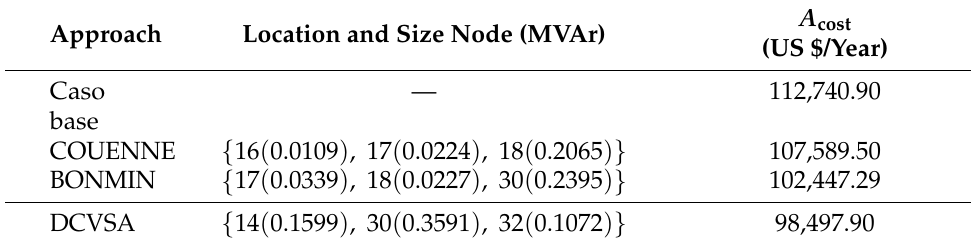
Table 7. Optimal location and sizes of the D-STATCOMs in the IEEE